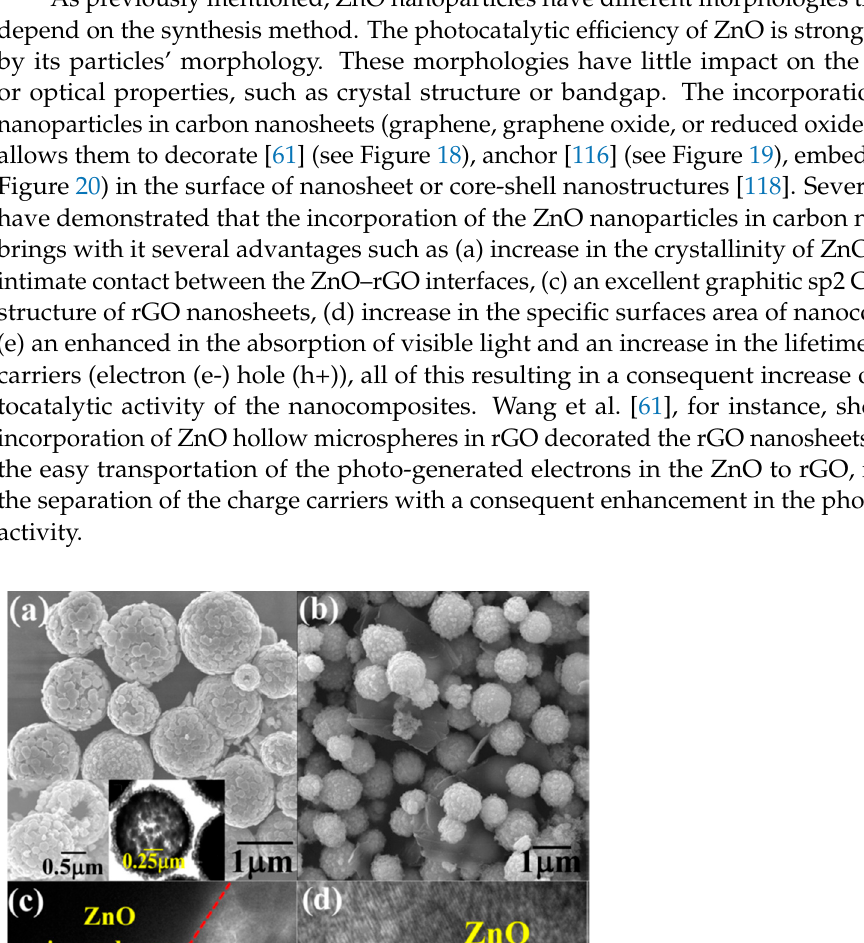
Figure 19. SEM images ( a – d ) of ZnO/rGO nanocomposite, TEM images ( e – g ), and corresponding size distribution ( h ) of ZG2 catalysts. Reproduced from [116] with permission from The Royal Society of Chemistry. Figure 20. ( a – c ) Morphological property of micro-dumbbell-shaped rGO/ZnO composites using scanning electron microscopy. Reprinted by permission from Springer: Journal of Inorganic and Organometallic Polymers and Materials [117] Copyright, 2019.